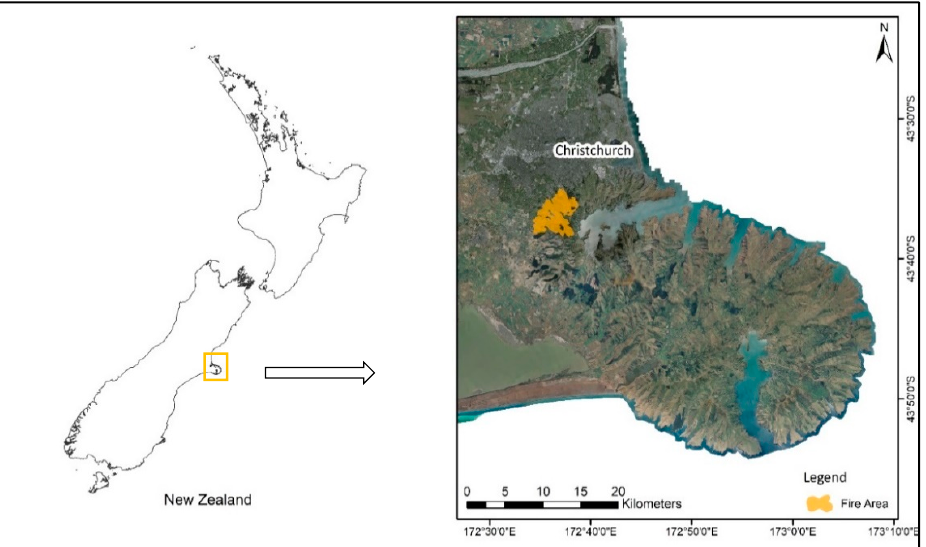
Figure 1. Location of the area affected by the wildfire (yellow polygon) on the Port Hills, near the city of Christchurch, New Zealand.